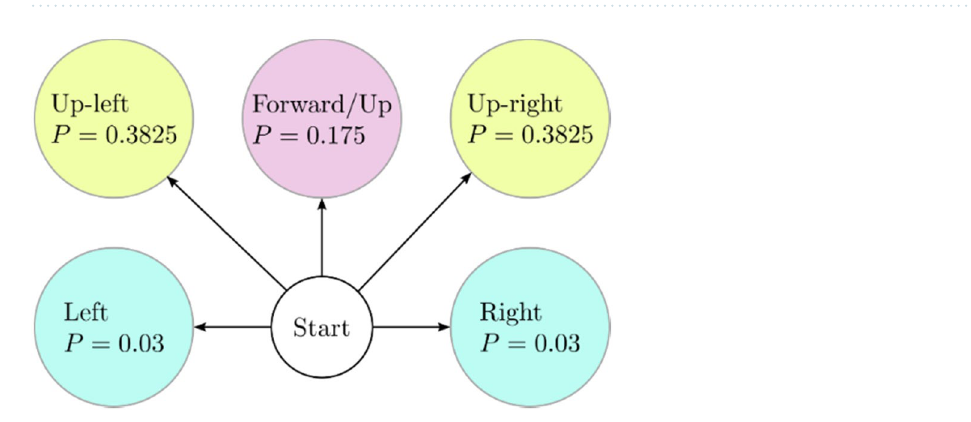
Figure 12. Random walker #2: crack orientations and their corresponding